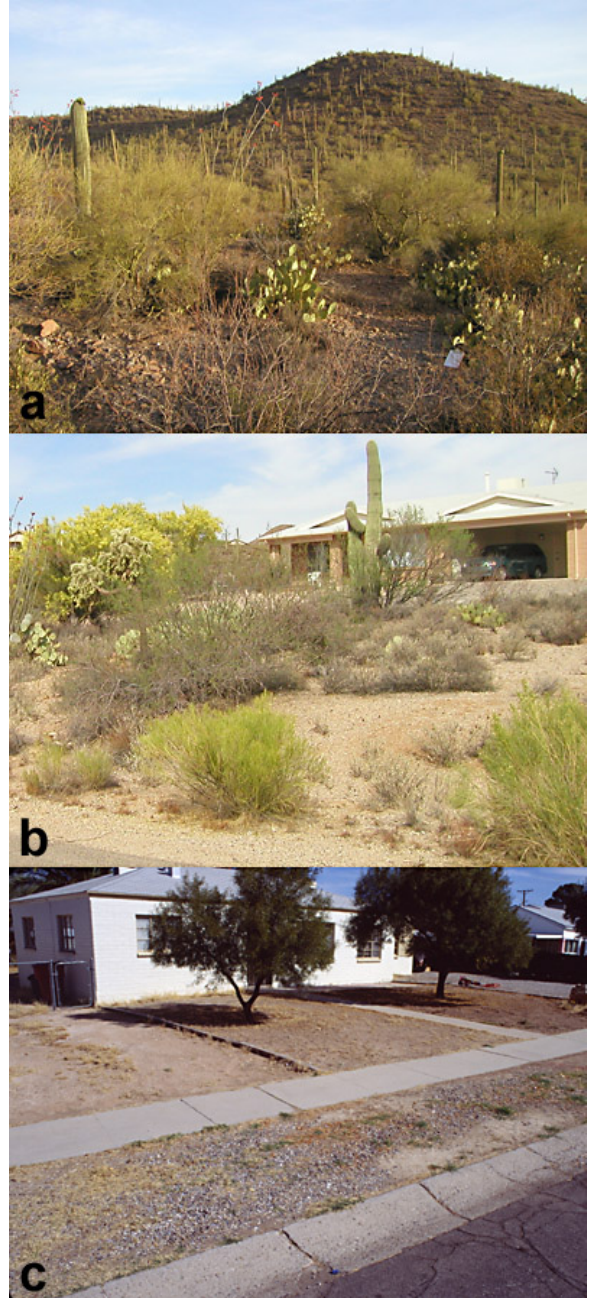
Fig. 1. Example photos showing variation in retention of native vegetation in the Tucson area. (a) nature reserve, comprising predominantly Sonoran desertscrub vegetation (photographer: Jim Hays). (b) residence retaining substantial desertscrub cover (photographer: Jim Hays). (c) residence with only non-native vegetation (photographer: Will